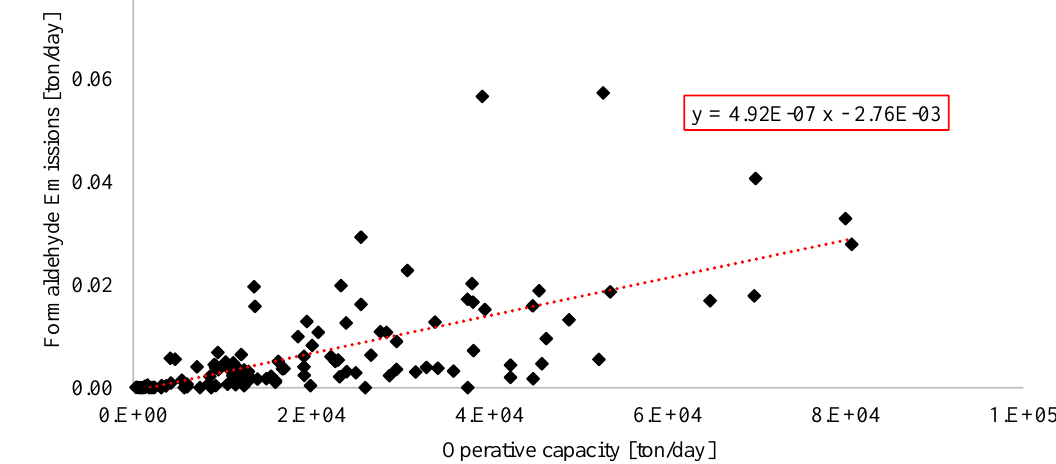
Figure 4. Total emissions of formaldehyde for 109 refineries.